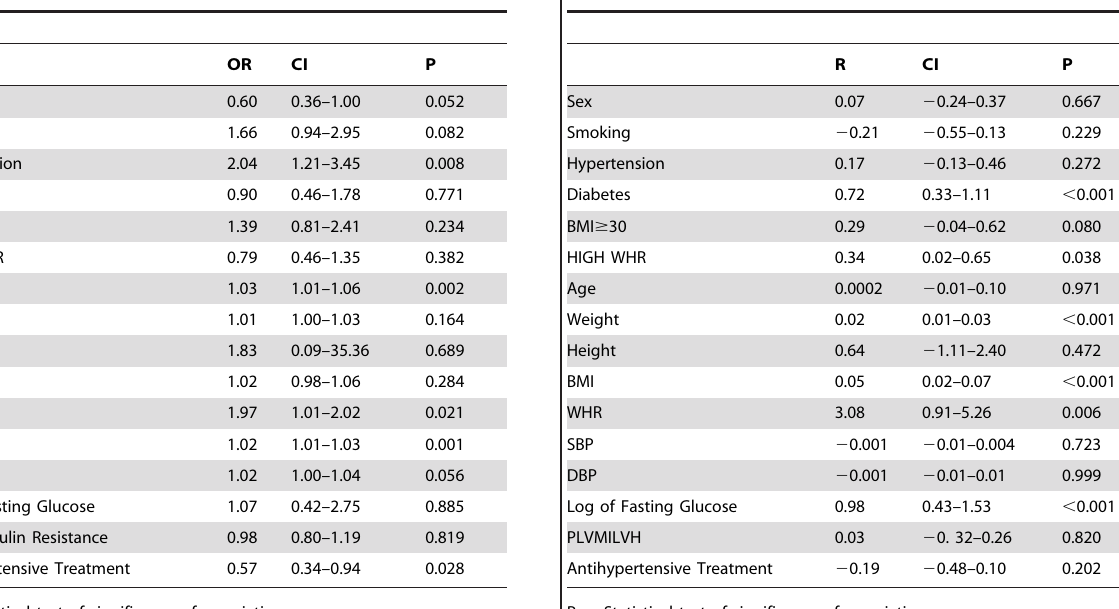
Table 5. Univariate analysis of variables with PVLMILVH as the outcome variable.